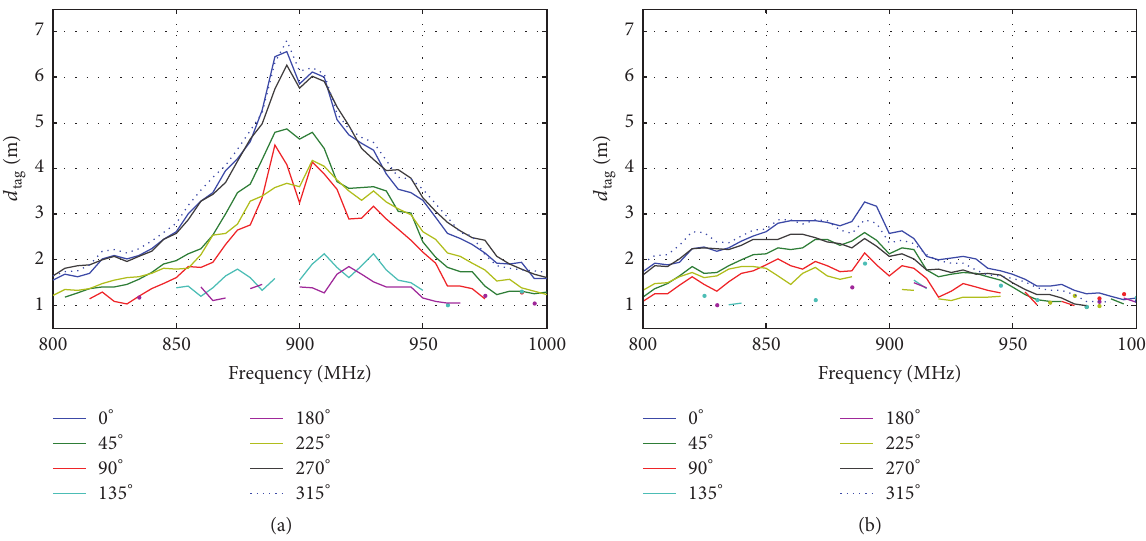
Figure 8: Measured attainable read range of the copper tape (a) and e-textile (b) tags attached to arm.